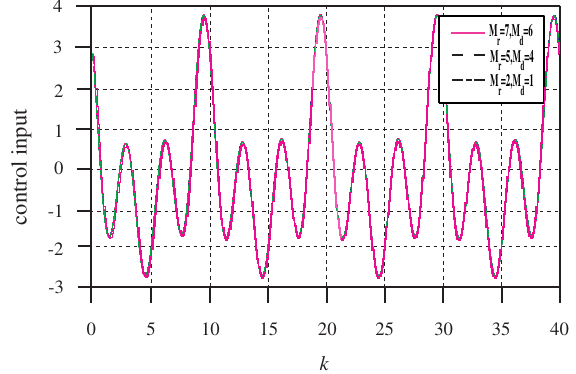
Figure 5. The control inputs with different preview